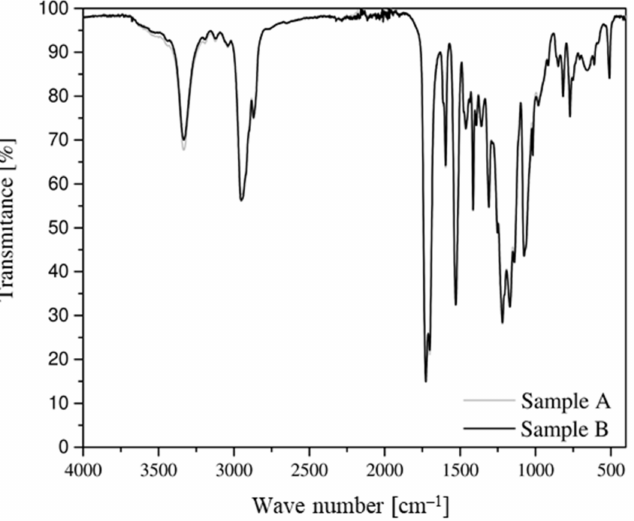
Figure 6. Absorption spectrum for the material of drive belt samples taken from both belt types, which was performed during a spectrophotometric